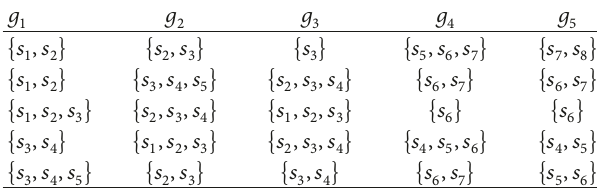
Table 1: Expert information matrix 𝐻 (1)